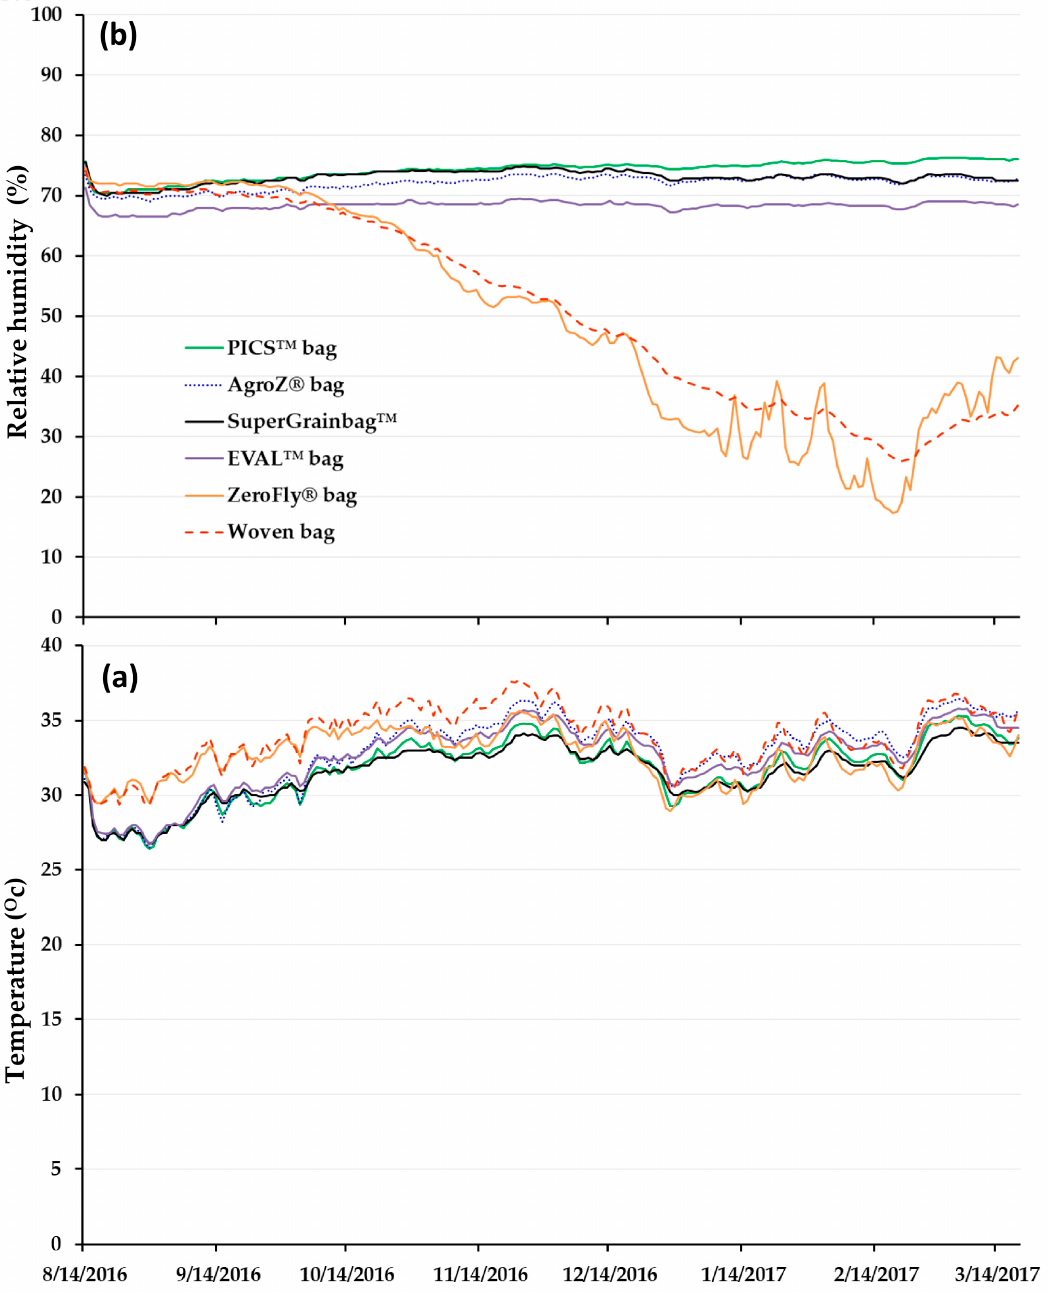
Figure 1. ( a ) Daily average temperature and ( b ) relative humidity variation in six types of storage bags filled with naturally infested maize stored for seven months in Parakou, Benin. Three days after setting up the experiment, daily average relative humidity differed among the six storage containers ranging from 72.0 ± 0.0 to 66.9 ± 0.0% ( F = 2267.00, 5/138, p < 0.001) (Figure 1b). Toward the third week of October, about two months after the experiment was set up, the relative humidity in both the PP woven and the ZeroFly ® bags was already trending lower. On the other hand, the relative humidity in all hermetic bags remained relatively constant. Around 5 March 2017